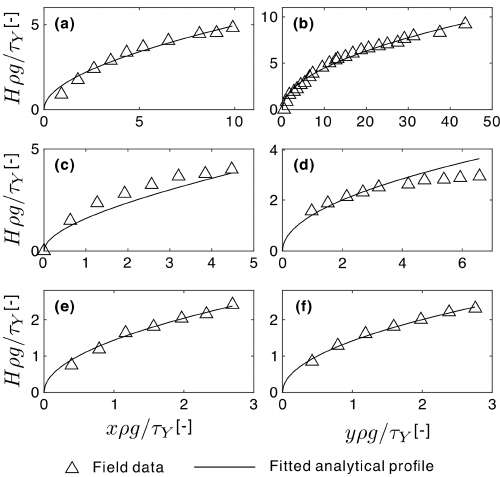
Figure 8. Comparison of debris deposit profiles at three field sites in the French Alps (Coussot et al., 1996) with analytical profiles calculated using calibrated values for parameters tan β , tan φ , and τ Y / ( ρg ): ( a , c , and e ) frontal profiles, ( b , d , and f ) lat- eral profiles, (a,b) Les Sables (tan β = 0 . 136, tan φ = 0 . 069, τ Y / ( ρg ) = 0 . 297m), (c,d) profiles for St-Julien (tan β = 0 . 296, tan φ = 0 . 262, τ Y / ( ρg ) = 0 . 432m), and (e,d) profiles for Mont Guillaume (tan β = 0 . 245, tan φ = 0 . 028, τ Y / ( ρg ) = 0 .